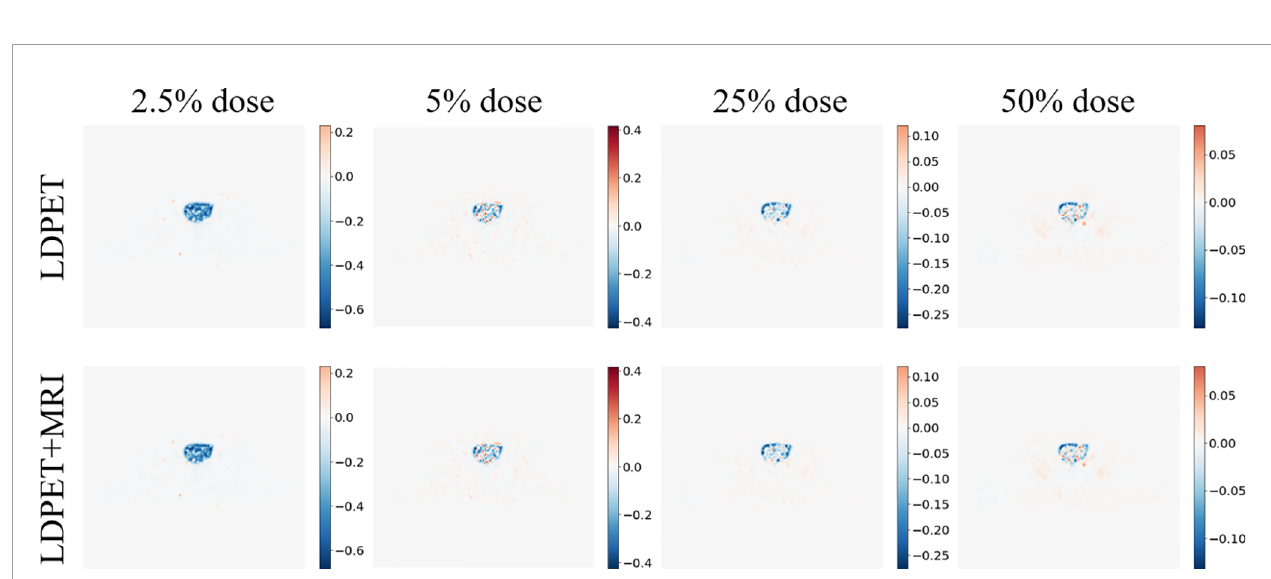
FIGURE 3 | The original LDPET images, synthesized FDPET images, MR prior-synthesized FDPET images of all doses, and their ROIs.